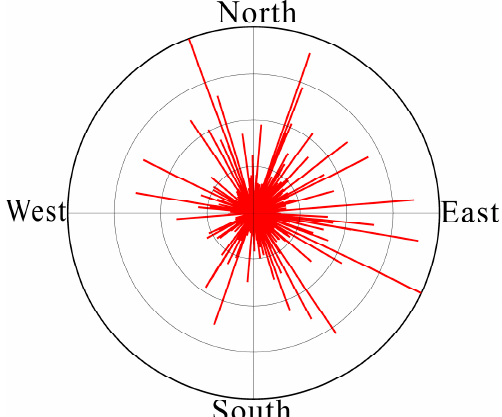
Figure 5. Azimuthal distribution of noise energy from tf-PWS. We normalized the SNR values by the biggest SNR measurements.